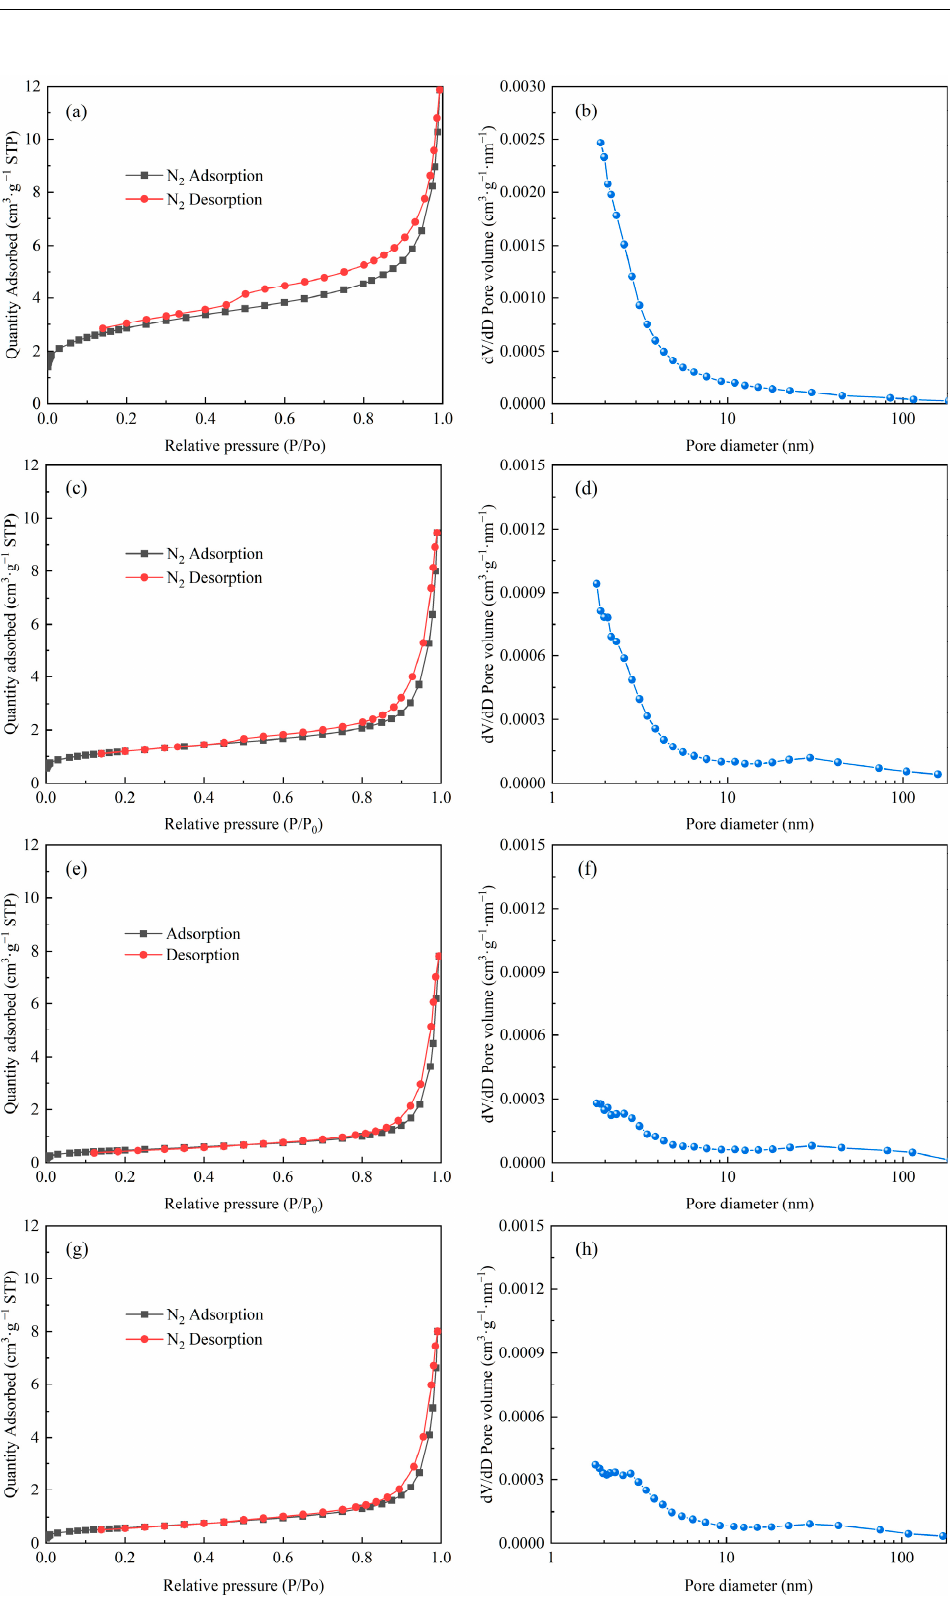
Figure 14. N 2 adsorption–desorption isotherms and pore size distribution of samples: ( a , b ) raw ore, ( c , d ) product pre-roasted for 40 min, ( e , f ) product roasted at 650 °C, and ( g , h ) product roasted under optimal conditions.